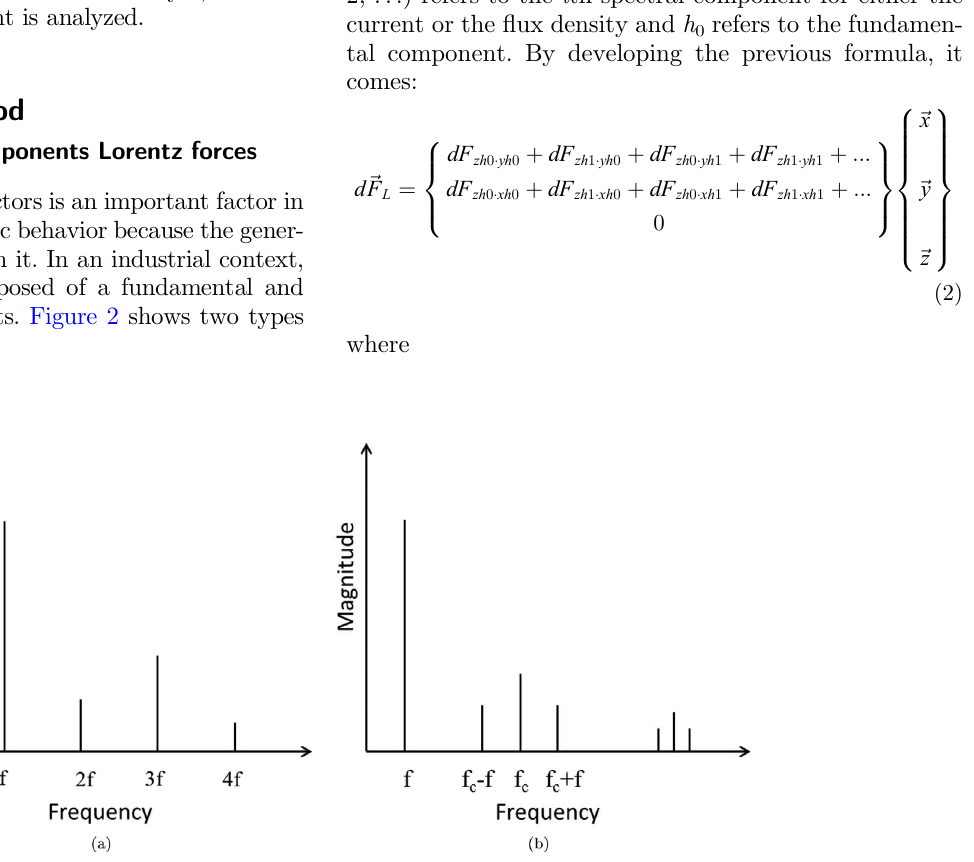
Figure 2. Typical current spectrum of an electrical grid with harmonic components (a) and with pulse width modulation (b).